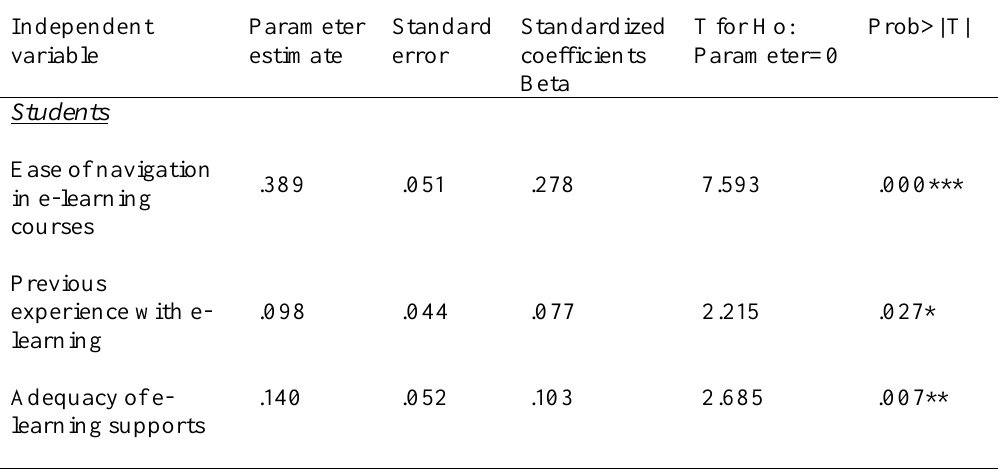
Regression Analysis – Dependent Variable: Active Participation Independent variable